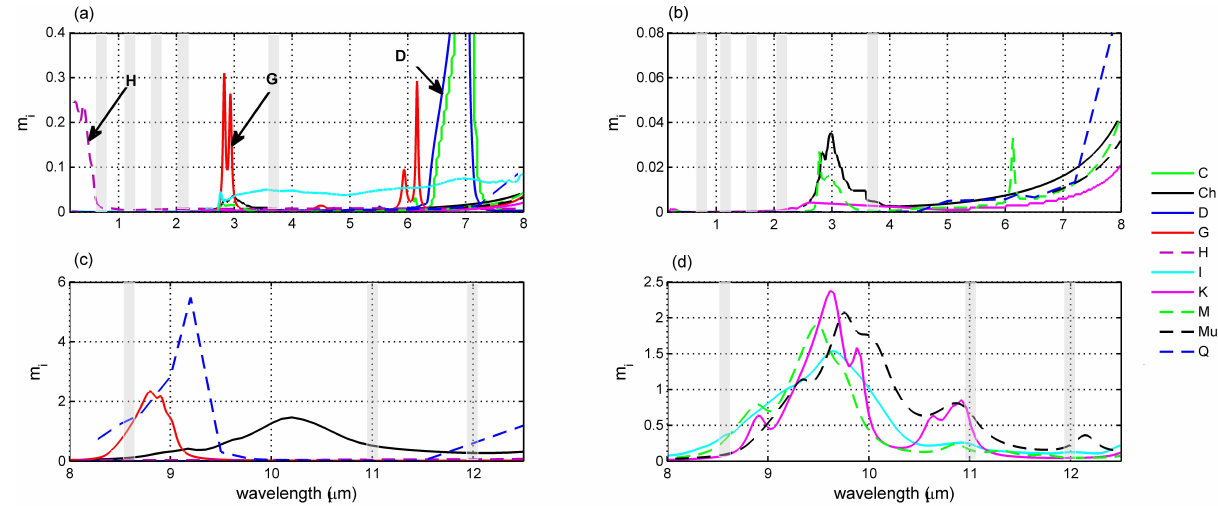
Fig. 1. Imaginary component of refractive index for common dust minerals, with vertical axes re-scaled to resolve spectral features. Gray shaded regions represent common remote sensing channels. Shown are the minerals calcite (C), chlorite (Ch), dolomite (D), gypsum (G), hematite (H), illite (I), kaolinite (K), montmorillonite (M), muscovite (Mu) and quartz (Q). (a) strong absorbers for λ ≤ 8µm with D and C scaled down 5 × , (b) weak absorbers for λ ≤ 8µm, (c) Q, G, Ch, and H in the window region, and (d) same as (c) except for the clays and